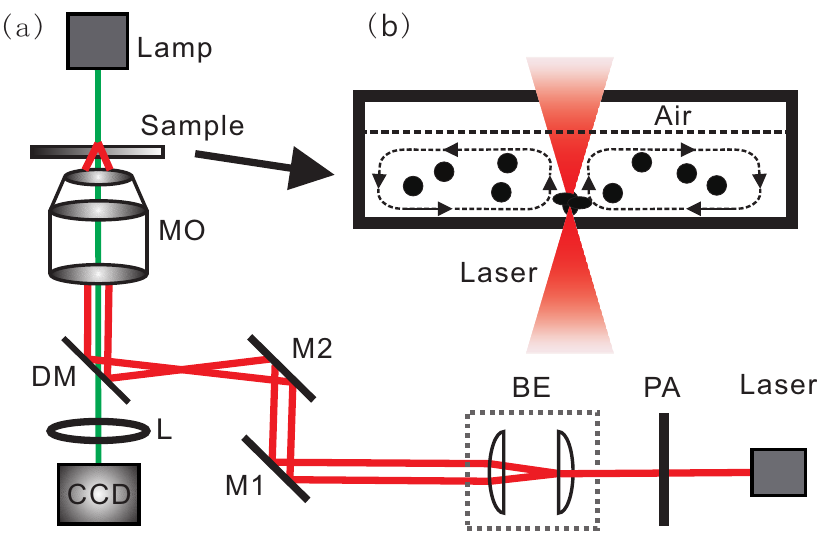
Figure 1. ( a ) Schematic of the experimental setup. PA, power attenuation; BE, beam expander; M1–M2, mirrors; DM, dichroic mirror; L, lens; MO, microscope objective; CCD, CCD camera. ( b ) Schematic illustration of Marangoni convection-induced particles accumulation inside the sample